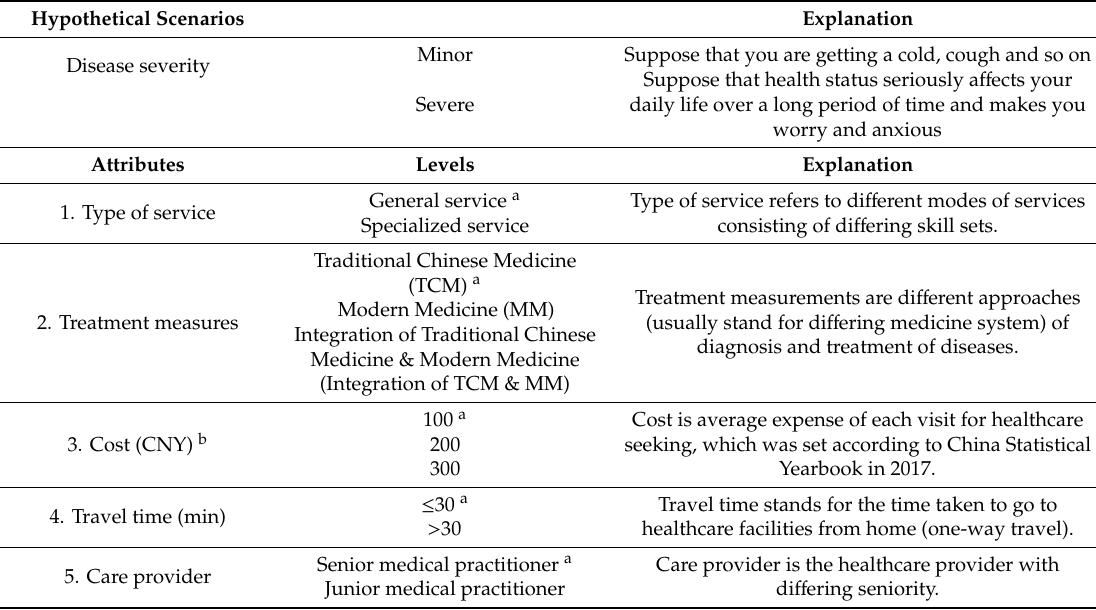
Table 1. DCE Attributes and Attribute